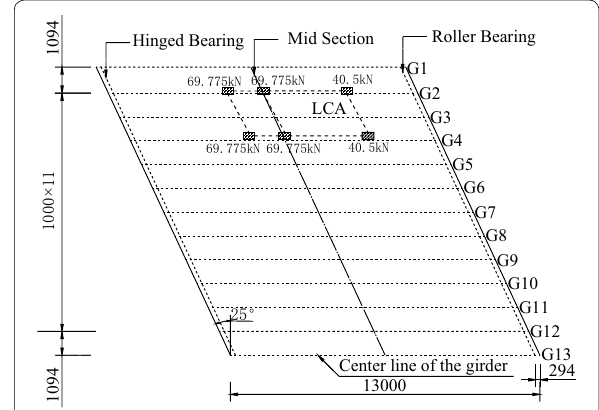
Fig. 6 Loading vehicle measurement (units: mm).